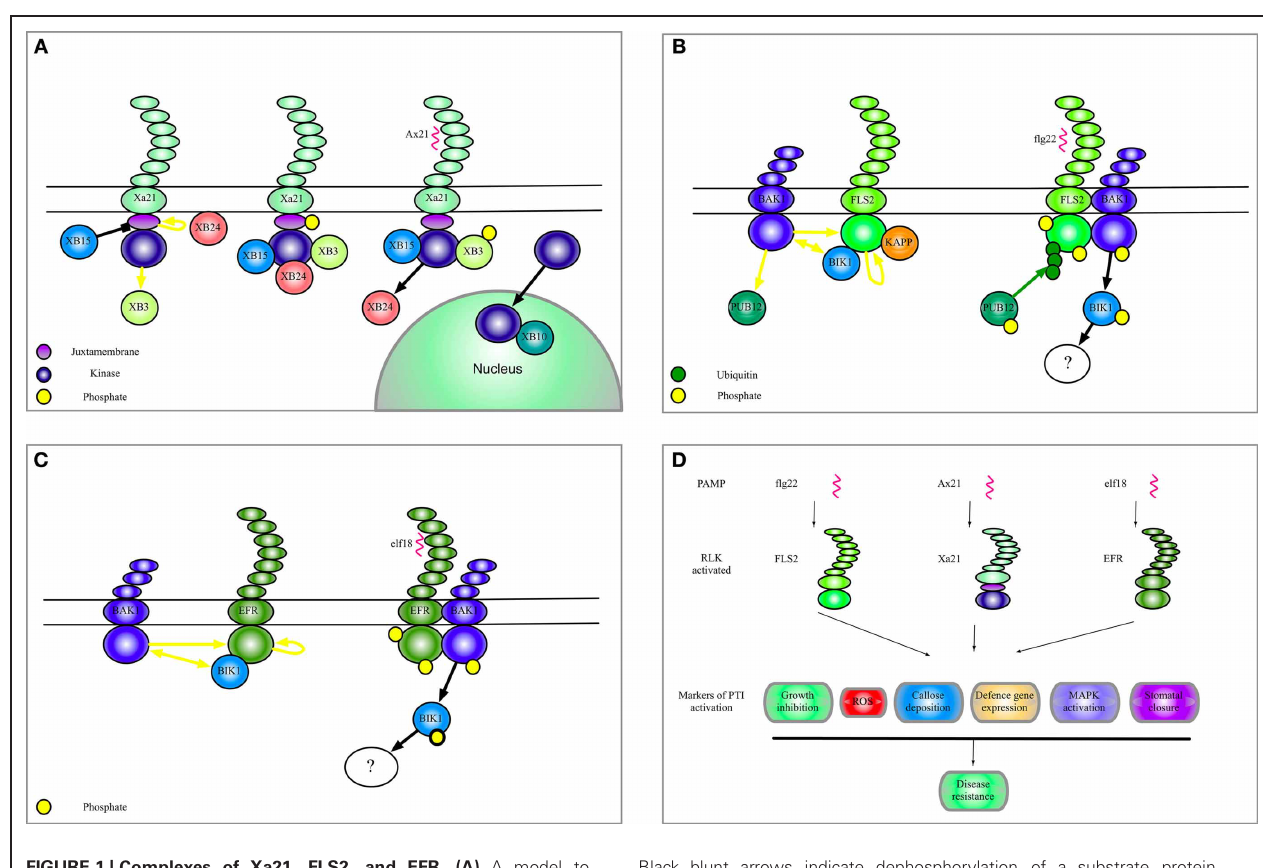
FIGURE 1 | Complexes of Xa21, FLS2, and EFR. (A) A model to summarize the current data regarding Xa21 function as discussed in this manuscript. (B) Illustration of the complexes formed by the RLK FLS2. The yellow dots indicate phosphorylation of a protein. Yellow arrows indicate phosphorylation of a substrate protein.